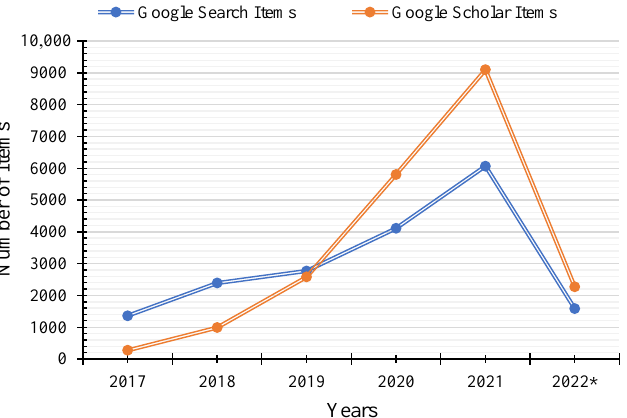
Figure 2. The popularity index of the term ‘explainable AI’ over the period of 2017–2022. Google Item Search indicates the queries in Google search engine, whereas Google Scholar Search points out the published studies available at Google Scholar (* results until March 2022 are extracted).